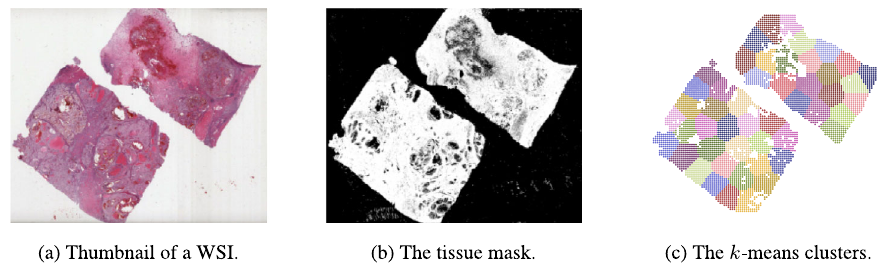
Fig. 4 An example of clustering for creating bag of tiles from a WSI. a Shows a thumbnail of a WSI, b shows the tissue mask obtained by segmenting the WSI, and c shows the clustered WSI using